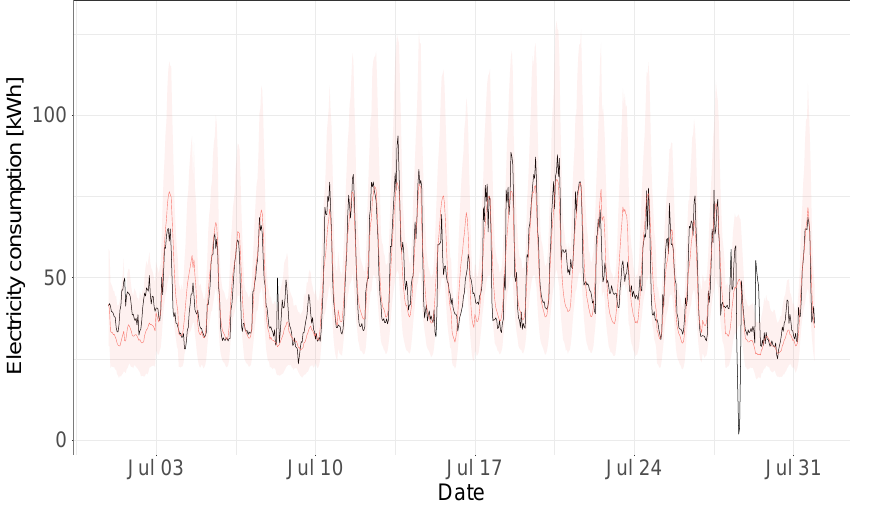
Figure 14. July 2017 metered electricity time-series (in black) and model predictions (in red) for Rat_health_Gaye